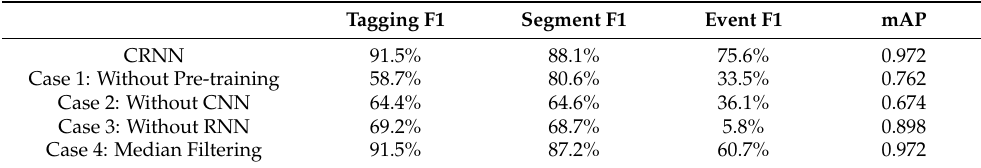
Table 5. The F1-score and mAP for ablation